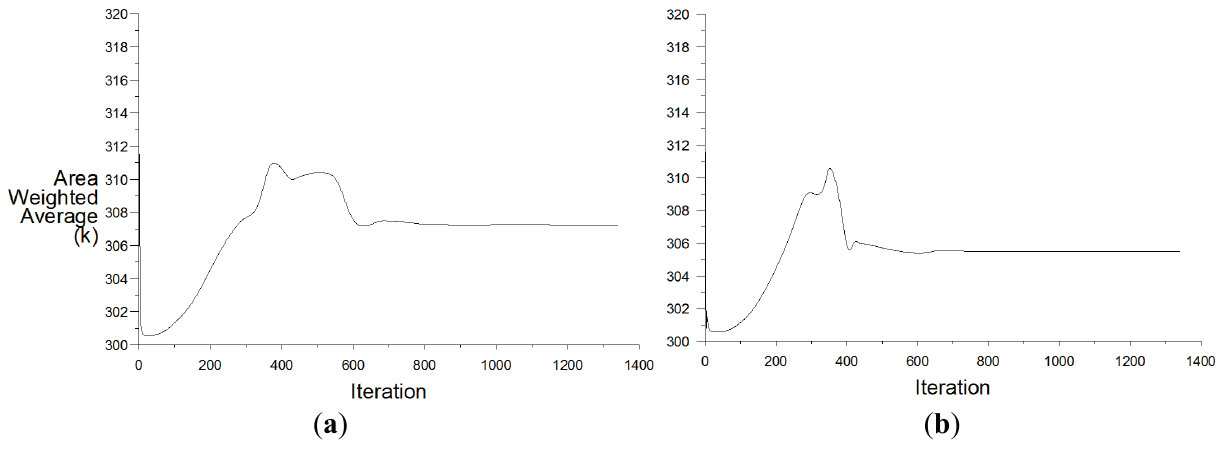
Figure 10. ( a ) Indoor temperature; and ( b ) air supply temperature